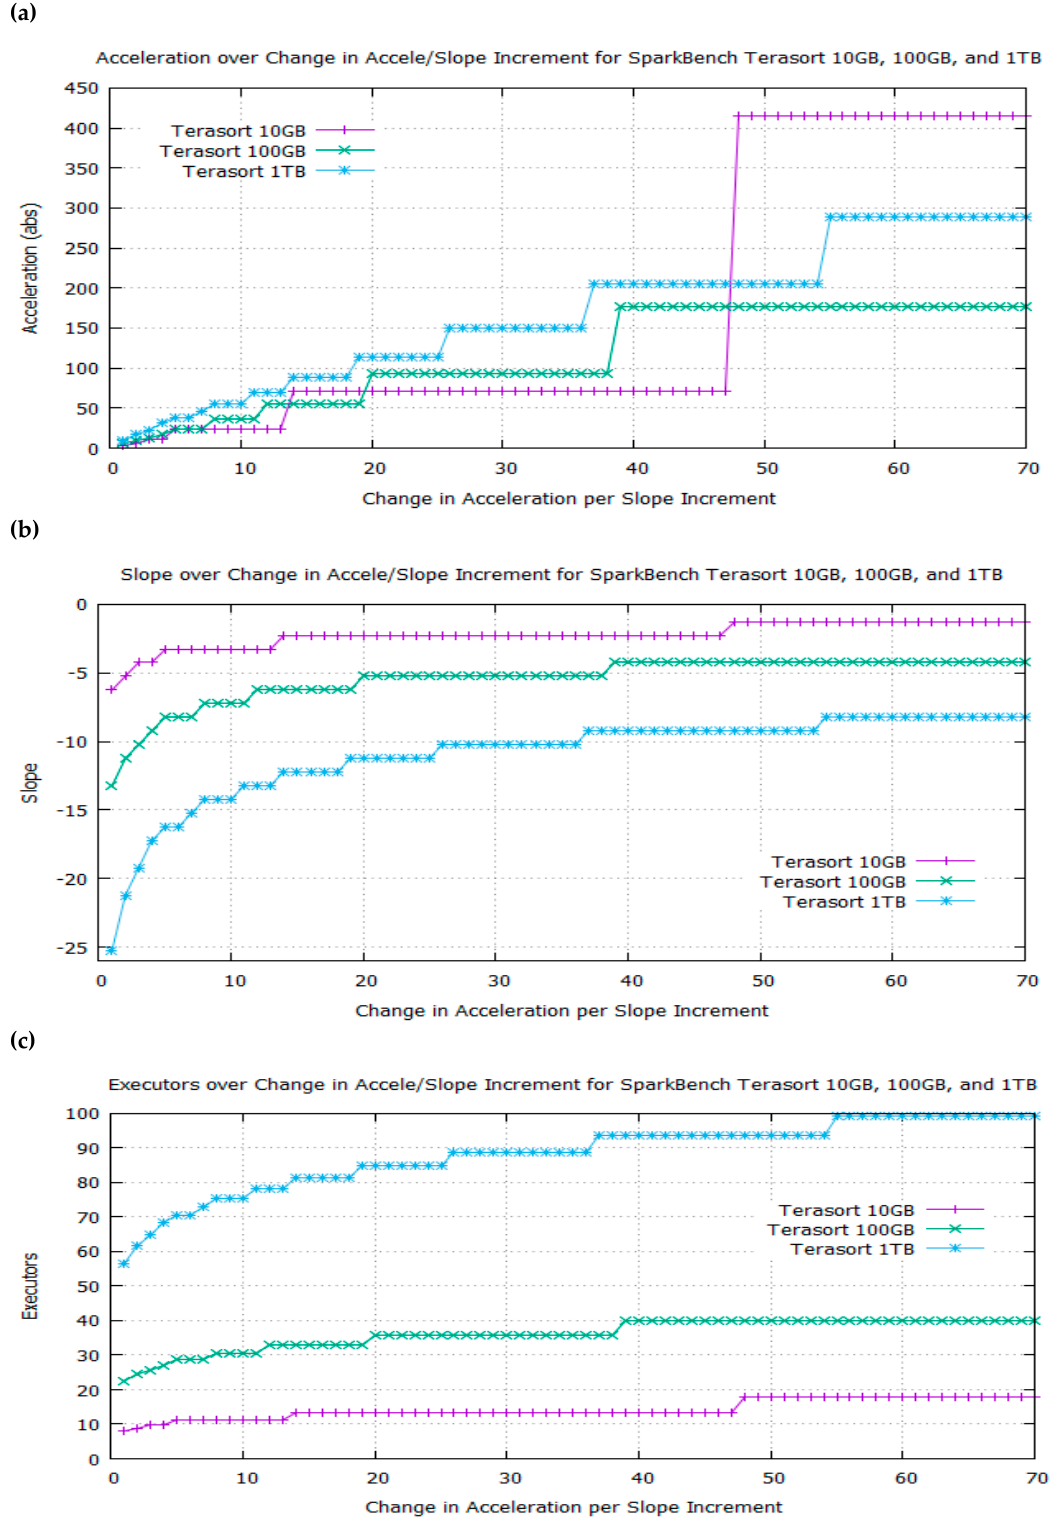
Figure 7 . The optimal numbers of executors for Spark-Bench Terasort 10 GB, 100 GB, and 1 TB workloads are identified by the major plateaus lasting at least seven increments on the graphs. The algorithm searches for break points in the changes in acceleration and outputs: ( a ) recommended acceleration, ( b ) corresponding slope and ( c ) executors versus change in acceleration per slope increment.